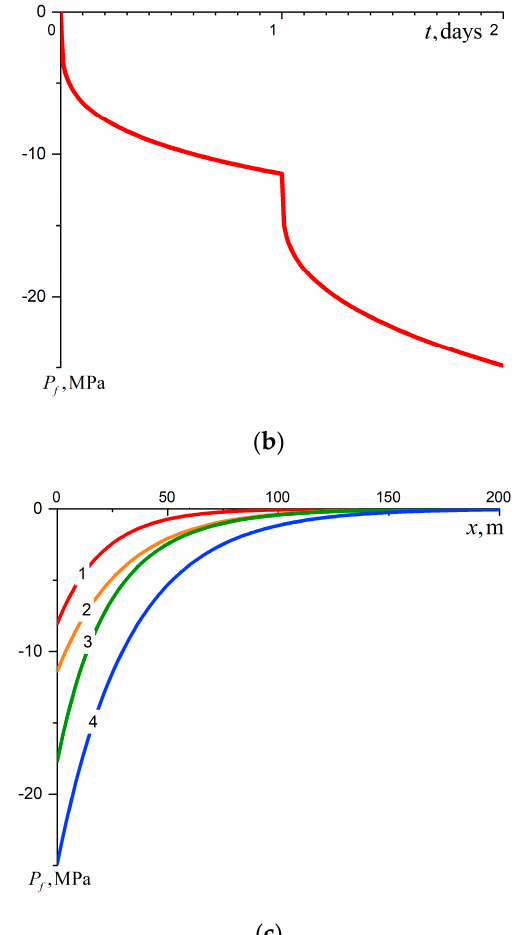
Figure 3. ( a ) two-stage change in fluid flow; ( b ) well-pressure change; ( c ) pressure evolution in hydraulic fracture.